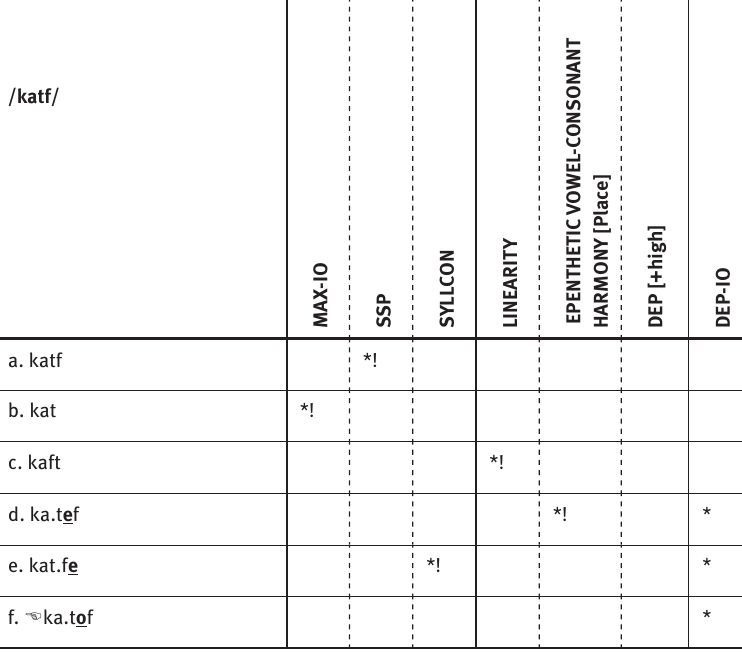
Table 10: MAX-IO, SSP, SYLLCON>>LINEARITY, EPENTHETIC VOWEL-CONSONANT HARMONY [Place], DEP [+high]>> DEP-IO